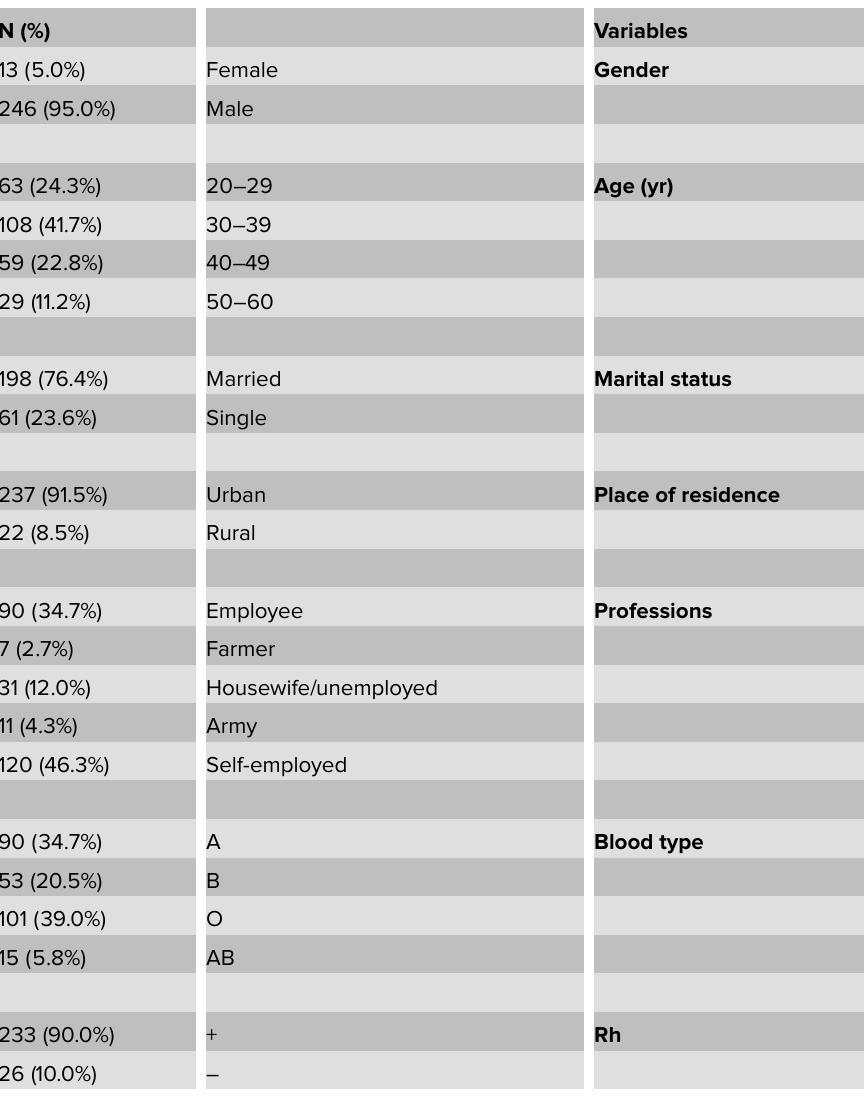
Table 1: Characteristics of the study